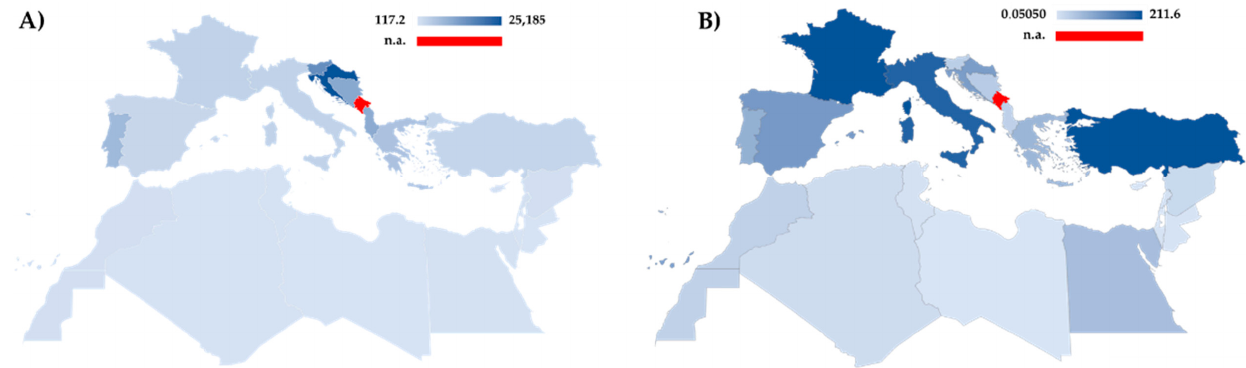
Figure 1. Total renewable water resources per capita ( A ) (m 3 /inhabitants/year) and total renewable water resources ( B ) (billion cubic meters) in Mediterranean Countries, 2017 [17].